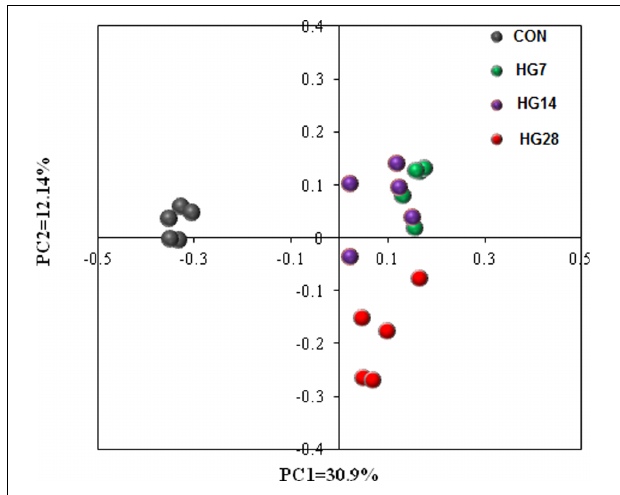
FIGURE 1 | Principal coordinate analysis (PCoA) of bacterial communities in colonic mucosa of sheep fed hay (CON) and a high grain (HG7–28) diet.